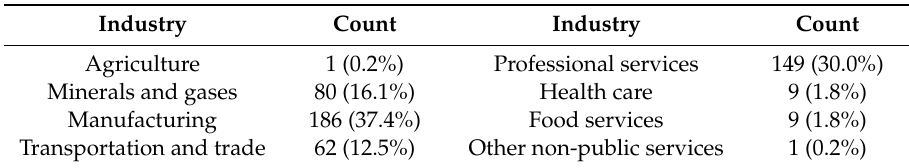
Table 6. Distribution of firms across industries (NAICS first